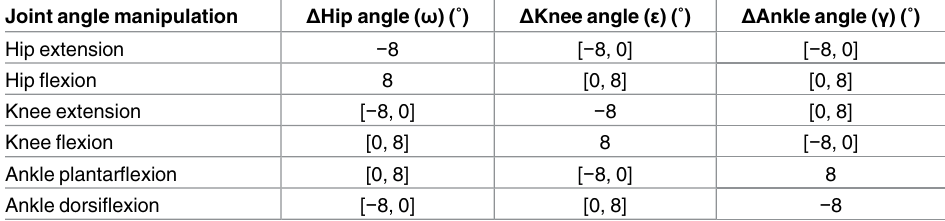
Table 2. Postural changes at the hip, knee and ankle during the joint angle